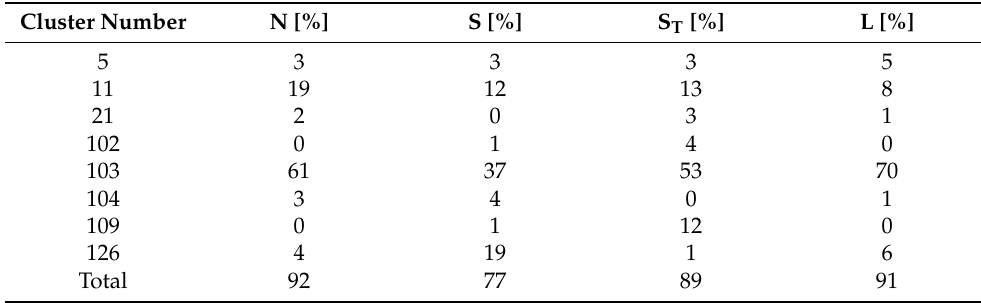
Table 3. Major clusters formed using a threshold of 0.65. For each type of specimen, the percentage of waveforms caught in the clusters is